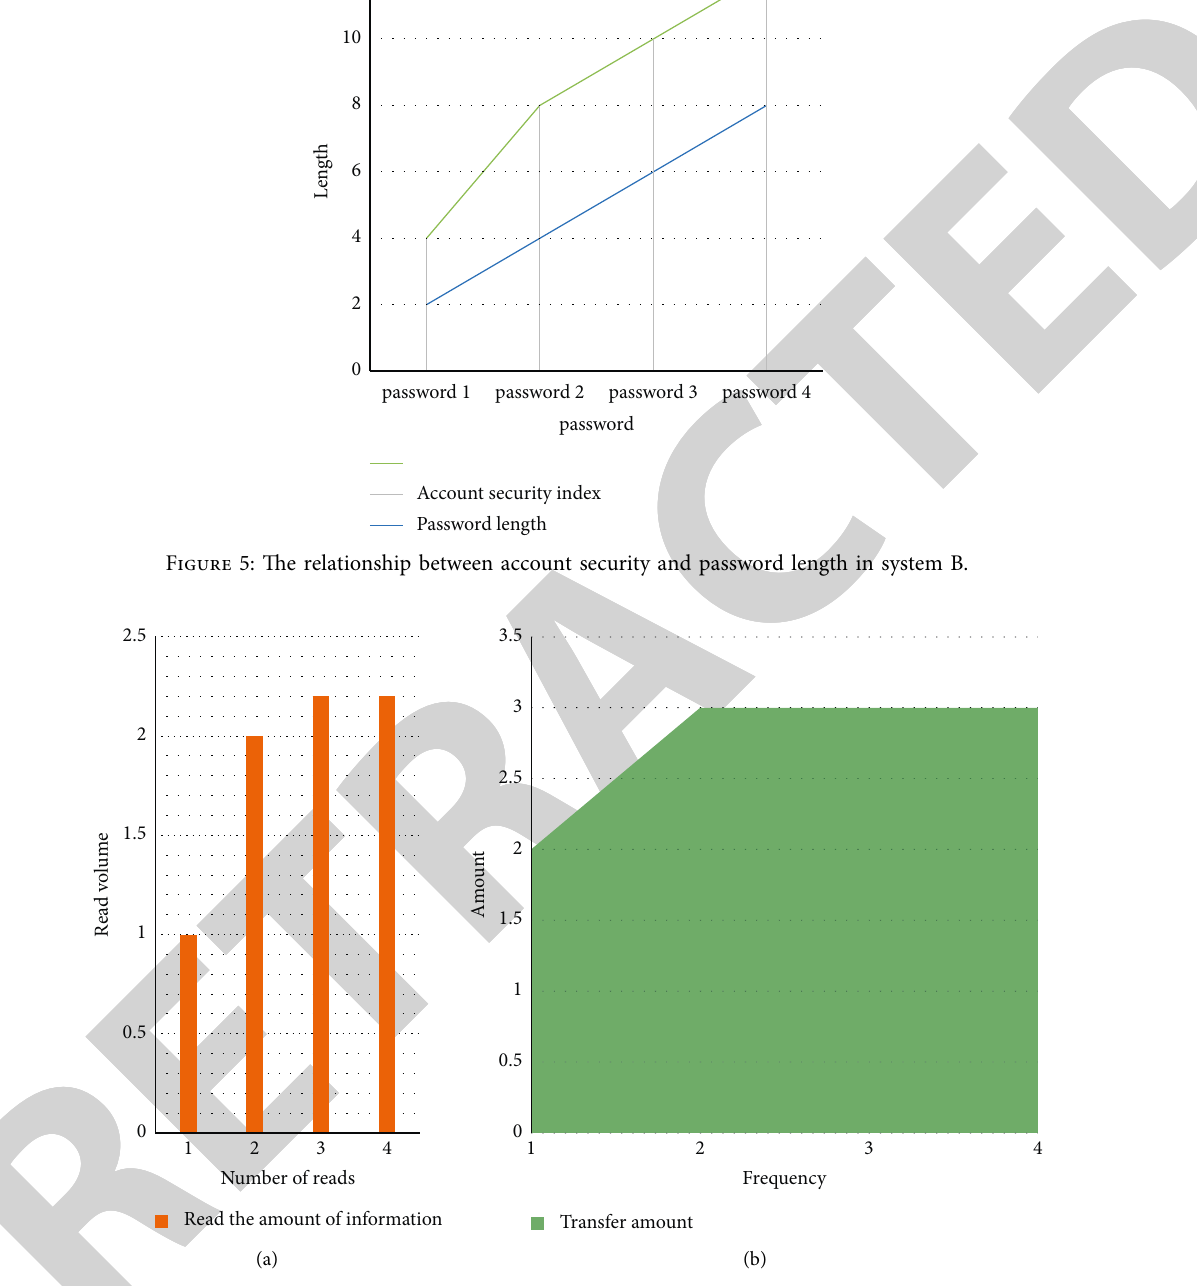
Figure 6: Difficulty of reading and transferring account information in system B. (a) Difficulty in reading system information. (b) Difficulty in transferring system information.